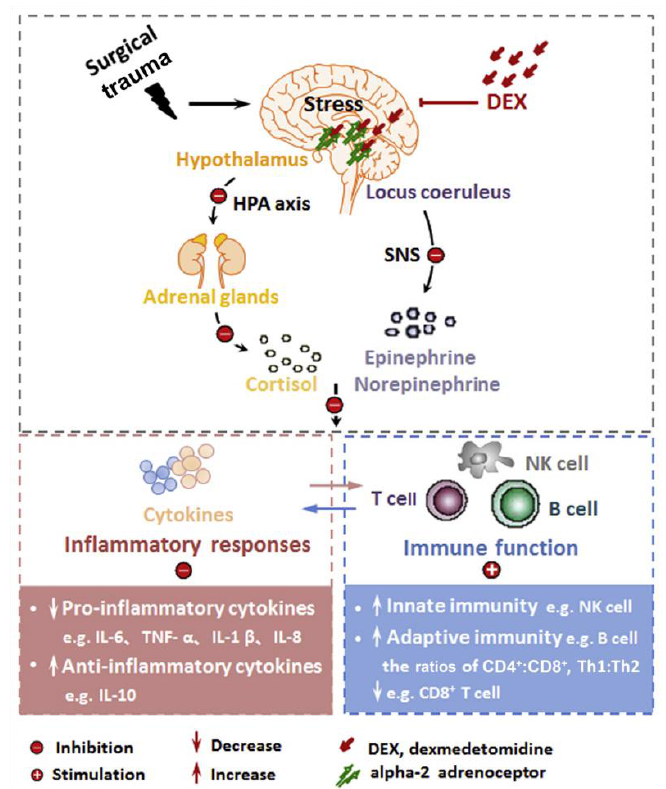
Figure 2. Schematic illustration that surgical trauma triggers perioperative stress, systemic inflammation, and immune suppression, all of which are negated by dexmedetomidine (DEX). HPA, hypothalamic-pituitary-adrenal; SNS, sympathetic nervous system [36].